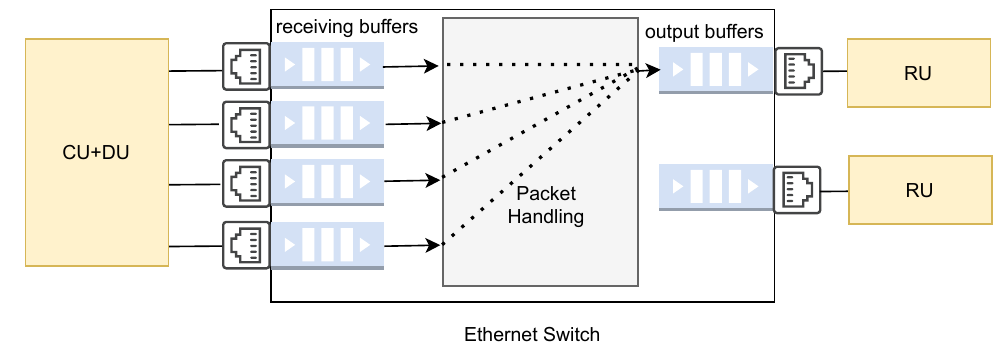
Figure 4. Switch internal